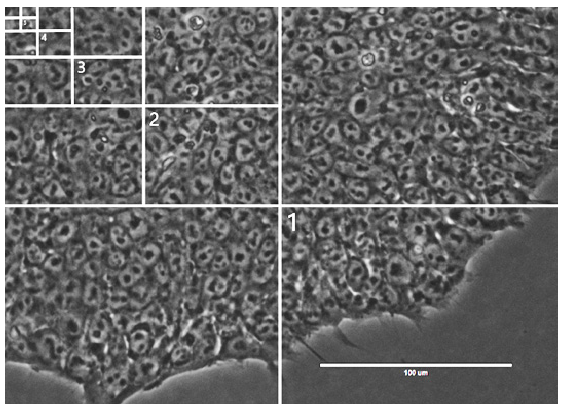
Figure 2. Illustration of the process of sequentially cutting an image into smaller pieces. The numbers in the figure indicate examples of images obtained at each step of this process.